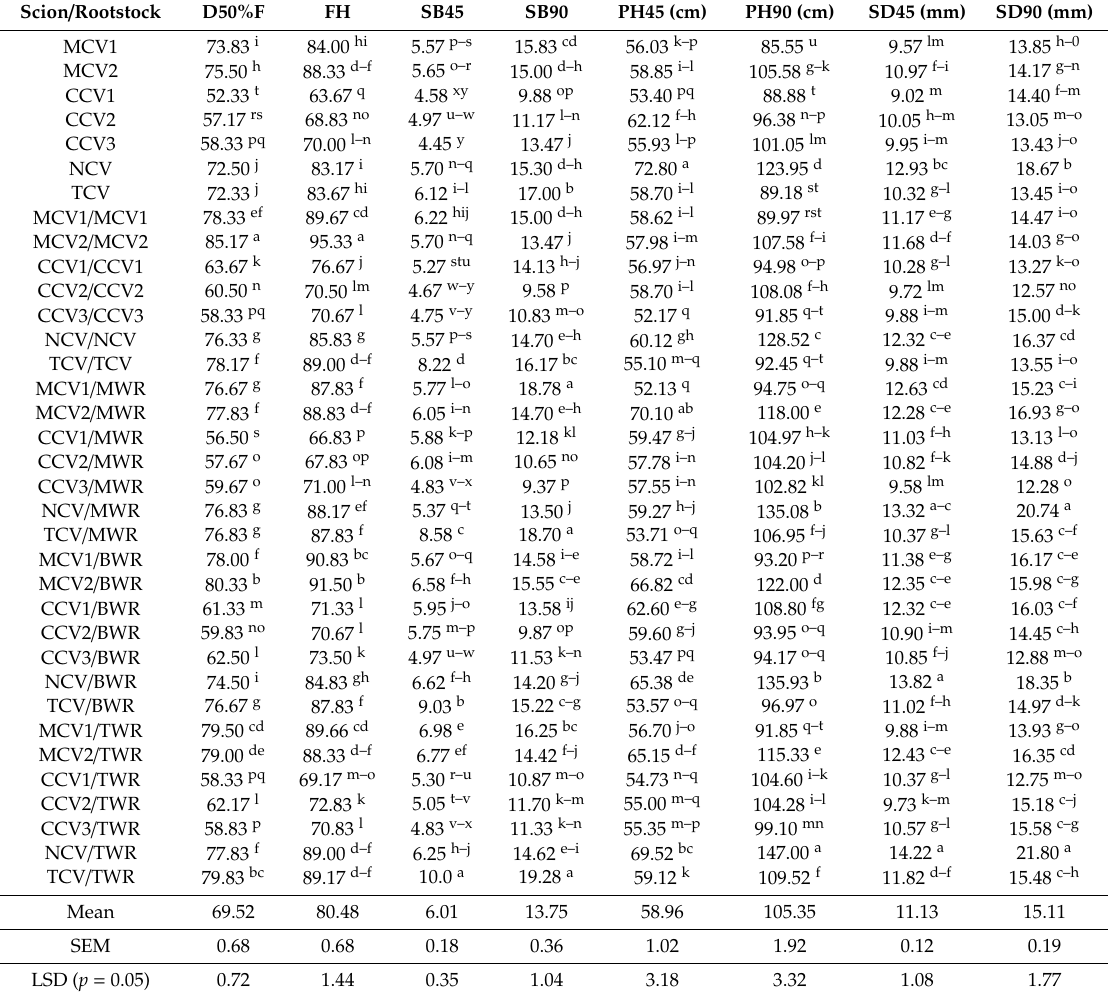
Table 3. Means of growth characters of the grafted, self-grafted and non-grafted eggplant genotypes studied across the cropping